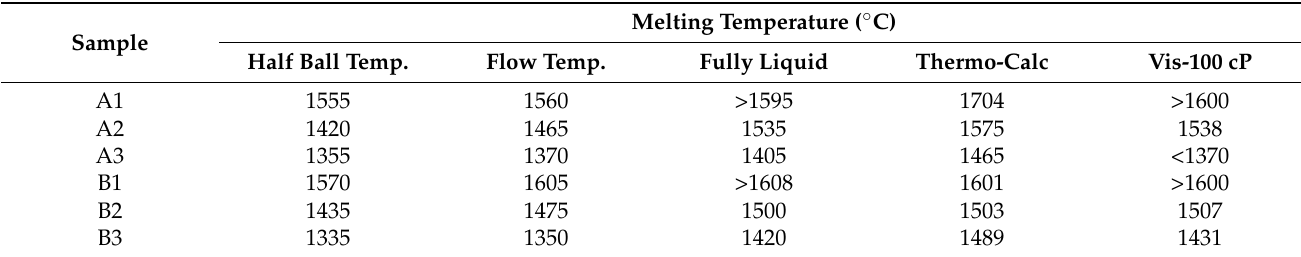
Table 4. Results of the high-temperature optical image observation, temperature of slags at viscosity 100 cp, and melting temperature simulated by Thermo-Calc software.